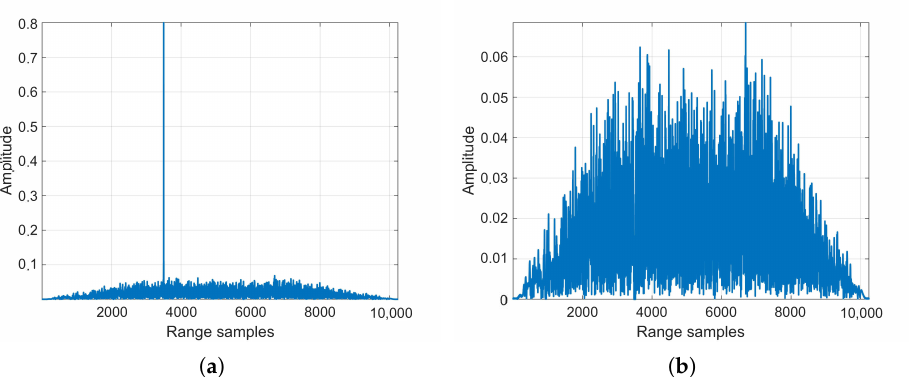
Figure 15. ( a ) A range line in Figure 14b (after pulse compression for synchronization signal). ( b ) A range line in Figure 14d (after removing synchronization signal and inverse pulse compression